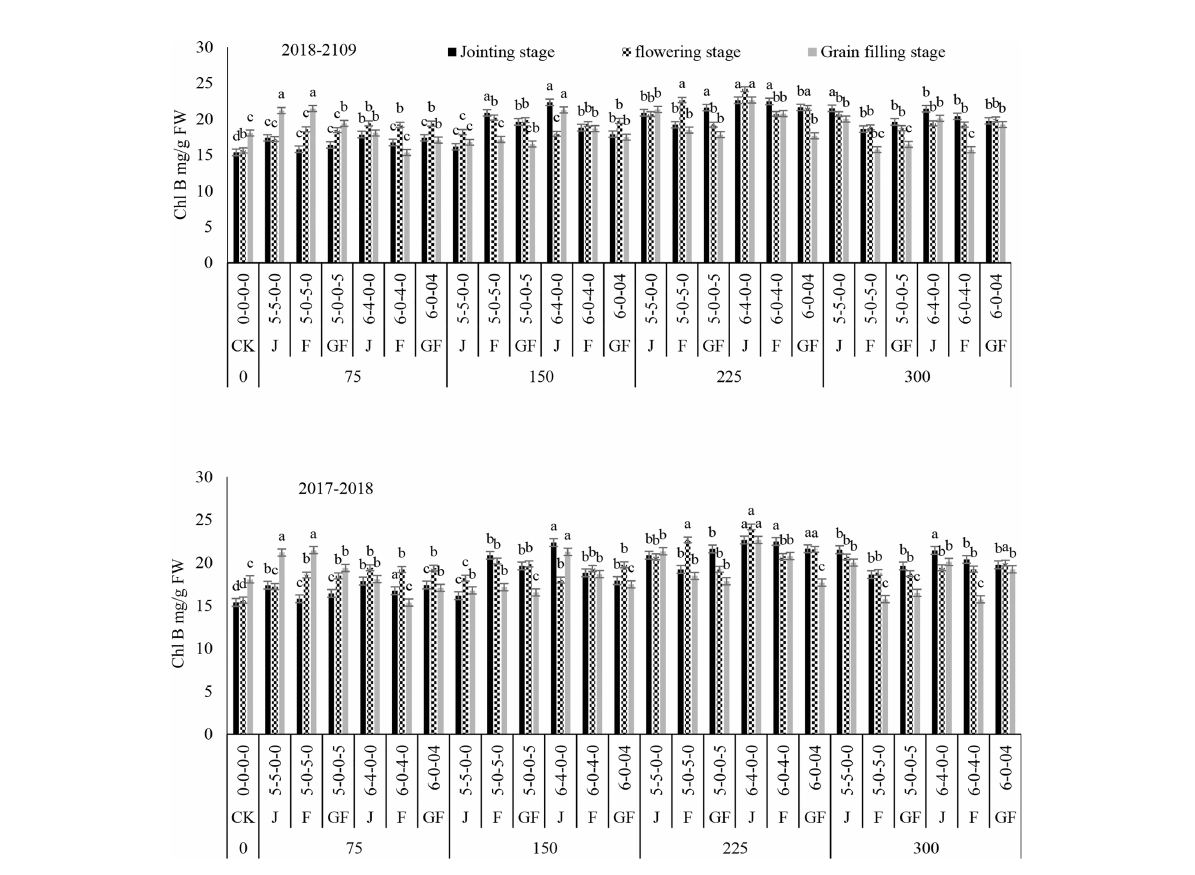
FIGURE 8 Effect of nitrogen fertilizer management on the Chl B content of winter wheat. FW , fresh weight; JS , jointing stage; FS , fl owering stage; GF , grain fi lling stage. Different letters in above bars indicate a signi fi cant difference